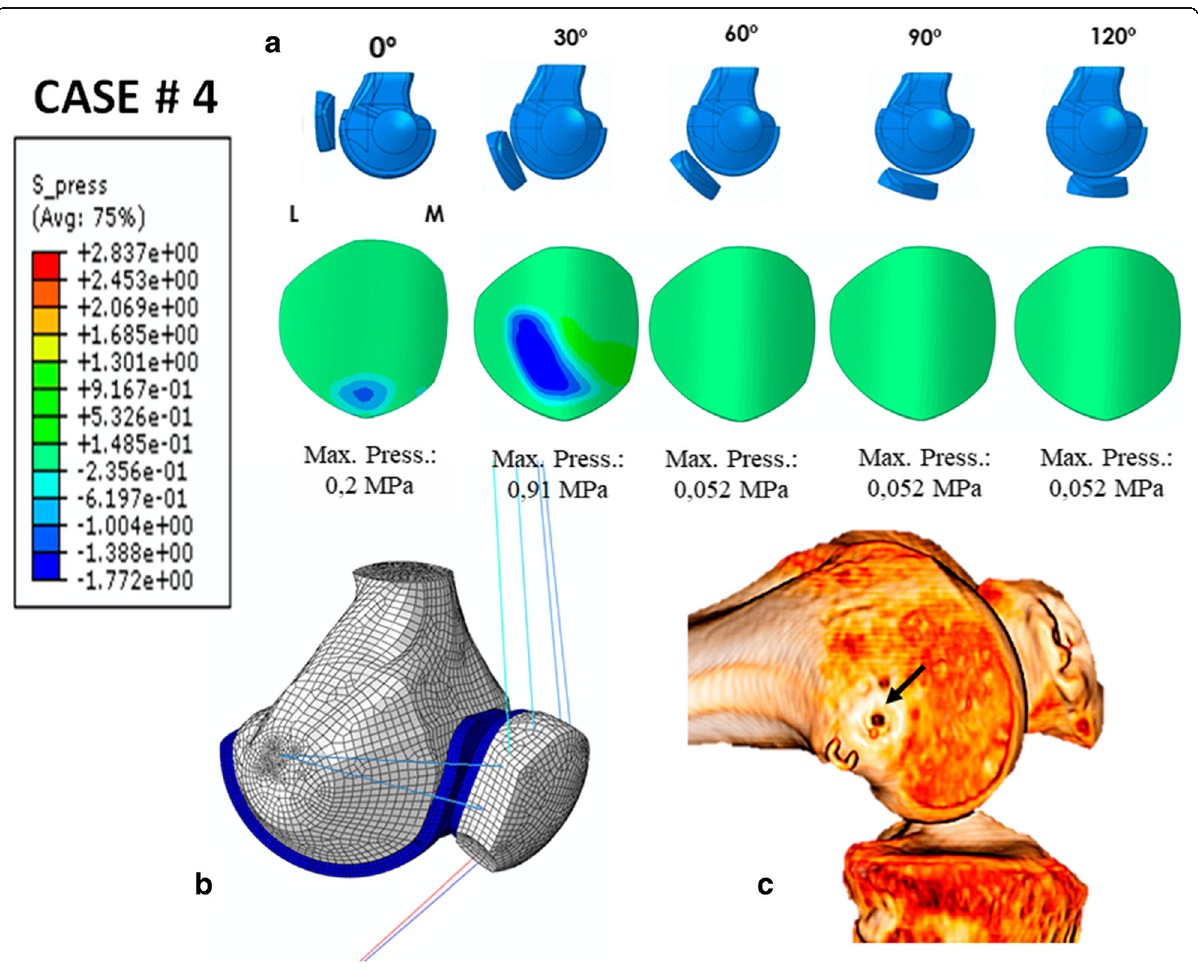
Fig. 7 Case # 4 Primary surgery with an excellent result: a Contact pressure (MPa) on the patellar cartilage L = Lateral M = Medial. b Parametric model of patient # 4. c Anatomic femoral attachment point (black